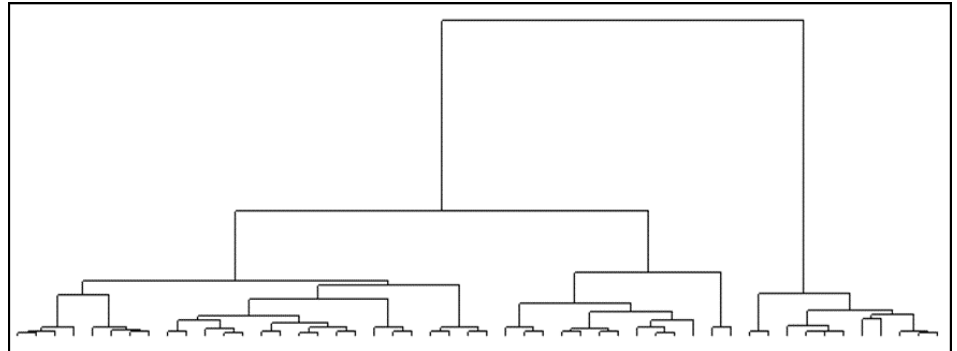
Figure 1. Dendrogram of the hierarchical cluster analysis.